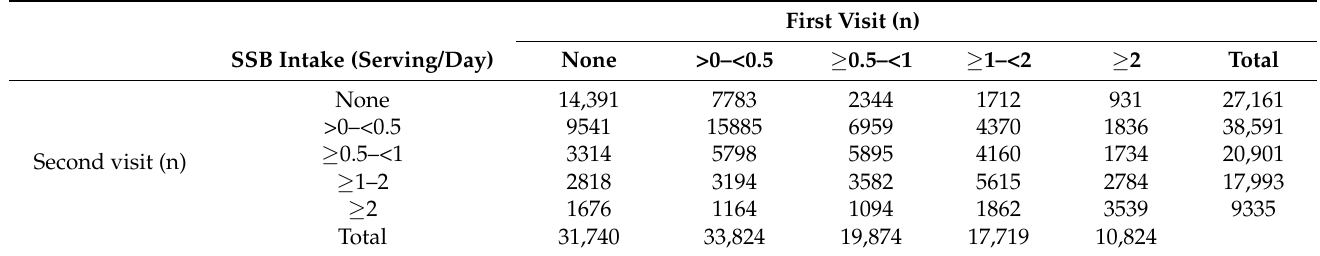
Table 4. Amount of sugar-sweetened beverage intake for participants with two